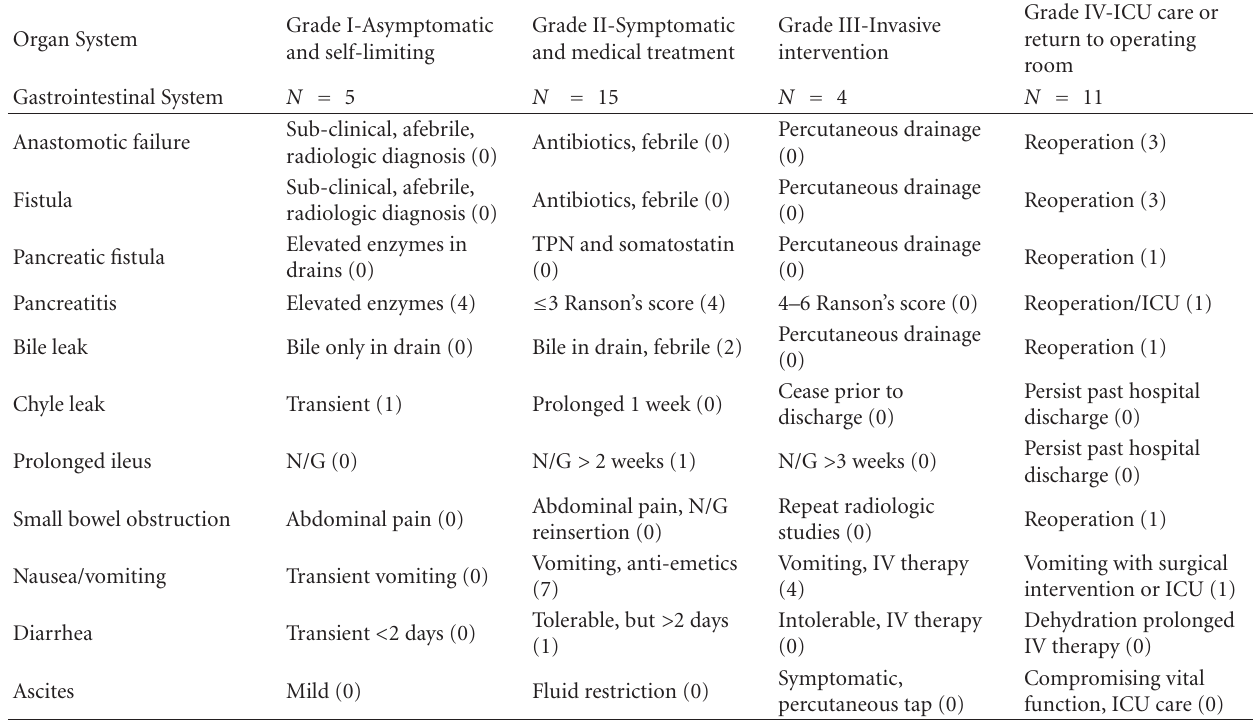
Table 2: The total number of gastrointestinal adverse events grade I through grade